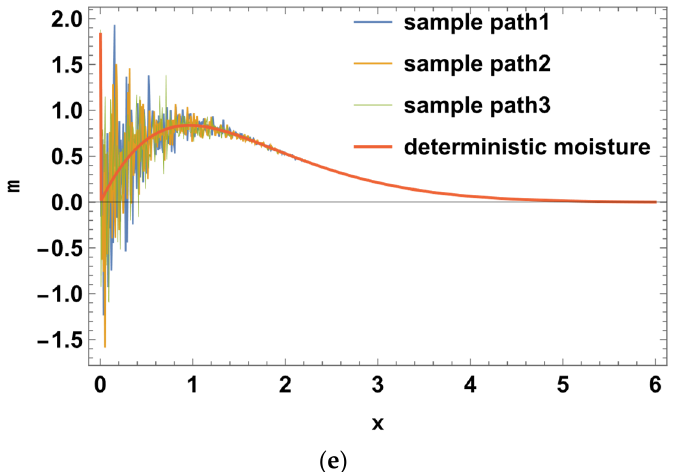
Figure 2. ( a – e ) The deterministic and stochastic distributions of temperature, normal stress, carrier density, displacement, and moisture distributions along the distance at 𝑡 = 0.04 in relation to generalized photo-thermoelasticity theory.